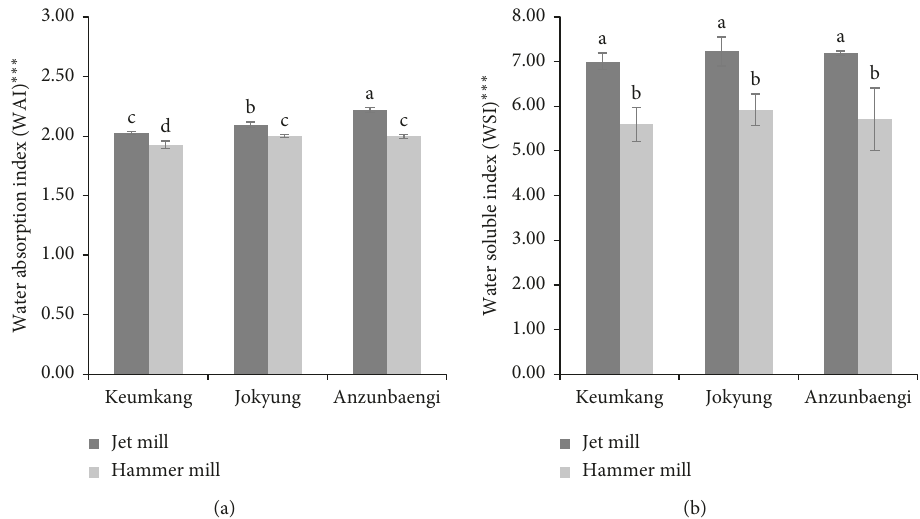
Significantly different ∗∗∗